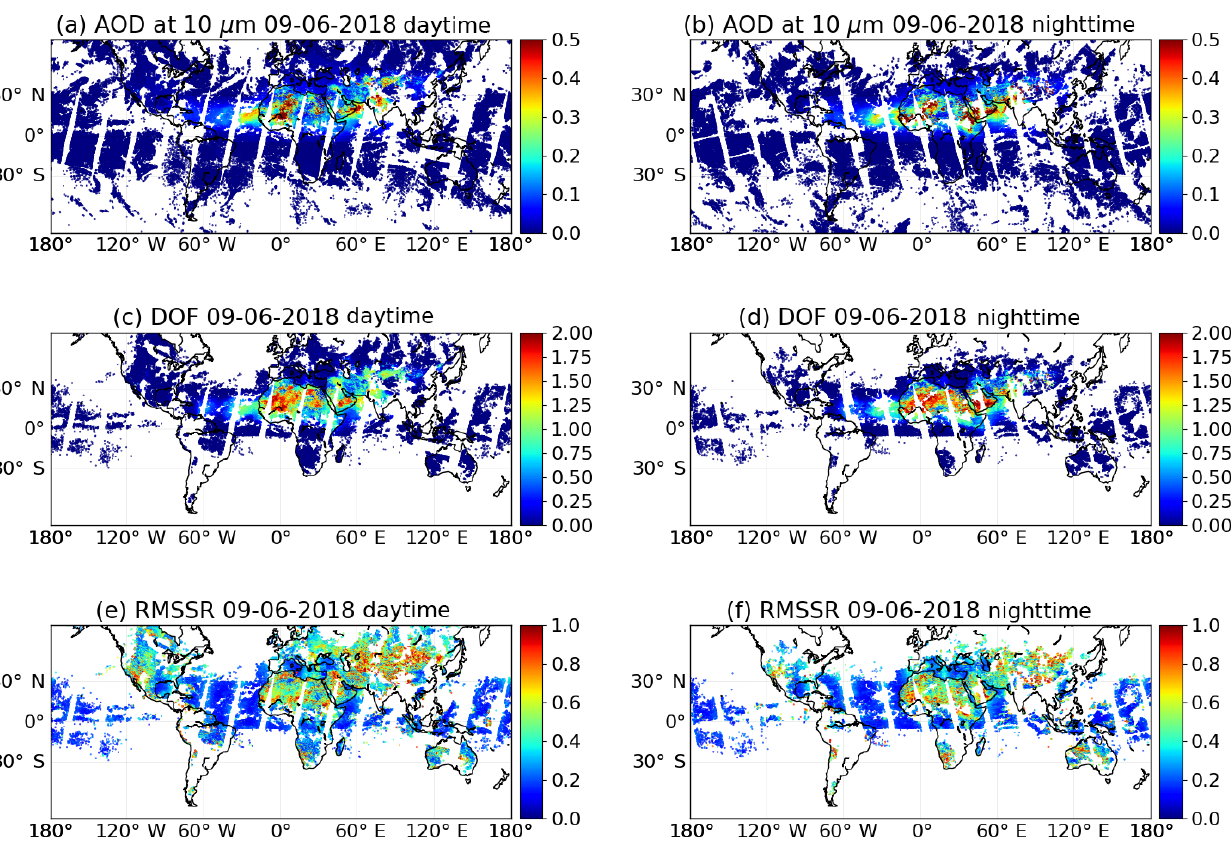
Figure 3. (a, b) Maps of the aerosol optical depth (AOD) at 10µm on 9 June 2018, calculated by integrating the retrieved aerosol profiles and multiplying them by the extinction cross section. (c, d) Maps of the degrees of freedom (DOF), June 2018. (e, f) Maps of the root mean square of the spectral residuals (RMSSR). Daytime (nighttime) measurements on the left (right) correspond to a mean local solar time of 09:30 (21:30) when crossing the